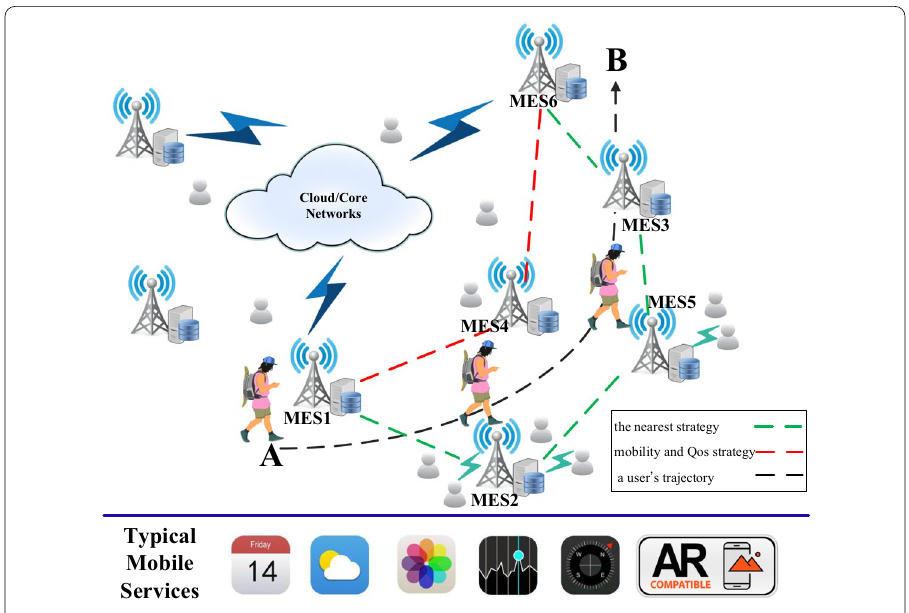
Fig. 1 Scenario of service recommendation in